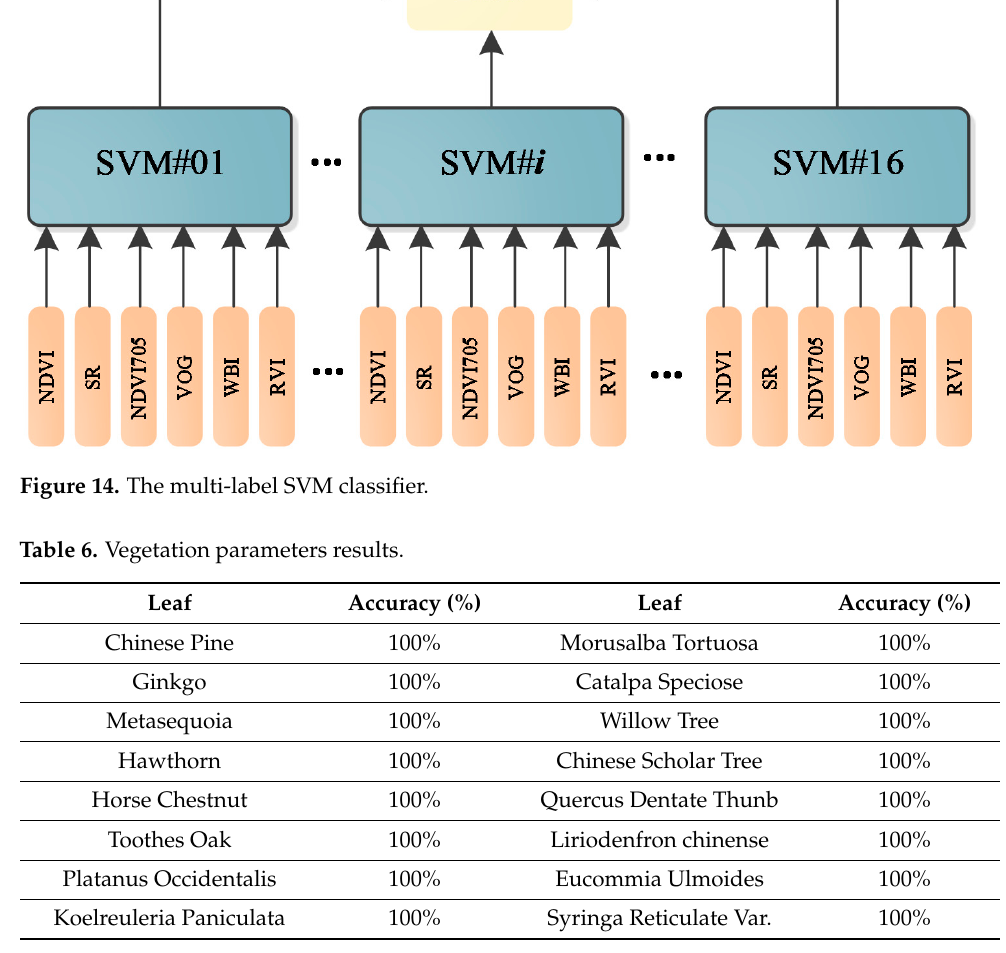
18 of 22 Figure 13. Normalized parameters of the employed leaves. Table 6. Vegetation parameters results. Leaf